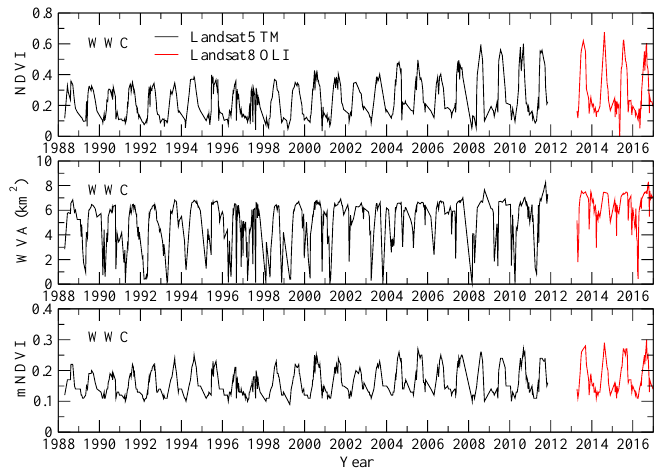
Figure 10. The time series plots of NDVI at the WWC’s typical wetland vegetation pixel ( top ), the wetland vegetated area ( center ), and the spatial mean NDVI ( bottom ) in the WWC. According to Figures 9 and 10, the wetland vegetation in the identified typical wetland vegetation pixels and the wetland vegetated area (WVA) and the spatial mean NDVI (mNDVI) of the entire wetland vegetation in the XTG and WWC all exhibited an increasing trend, especially during the past 20 years, which are clearly reflected in the annual maximum values that are directly related to the overall productivity and biomass in the entire wetland area [21,22]. Therefore, it is better to conduct the trend and correlation analyses of the annual maximum values rather than the entire time series of the computed NDVIs, WVAs, and mNDVIs. The time series plots of these peak values at the XTG and WWC are plotted in Figures 11 and 12, respectively. As shown in Figures 11 and 12, a significant increasing trend ( p < 0.01) was detected for each of the peak values (that is, NDVI, WVA, and mNDVI) at both the XTG and WWC during 1988–2016. Given the CMC’s snow depth dataset is from 1999 to 2016, the trend analysis was also performed for each time series plot of peak values during 1999–2016 (see Figures 11 and 12). Similar to the detected trends during the past 30 years, all trends during the past 20 years were also positive and significant ( p < 0.01). Almost all the trends of the past 20 years except for the peak NDVI trend at the XTG are greater than those of the past 30 years, especially the growth rate of the peak WVA (wetland vegetated area) at the WWC during 1999– 2016 which increased by 80%.